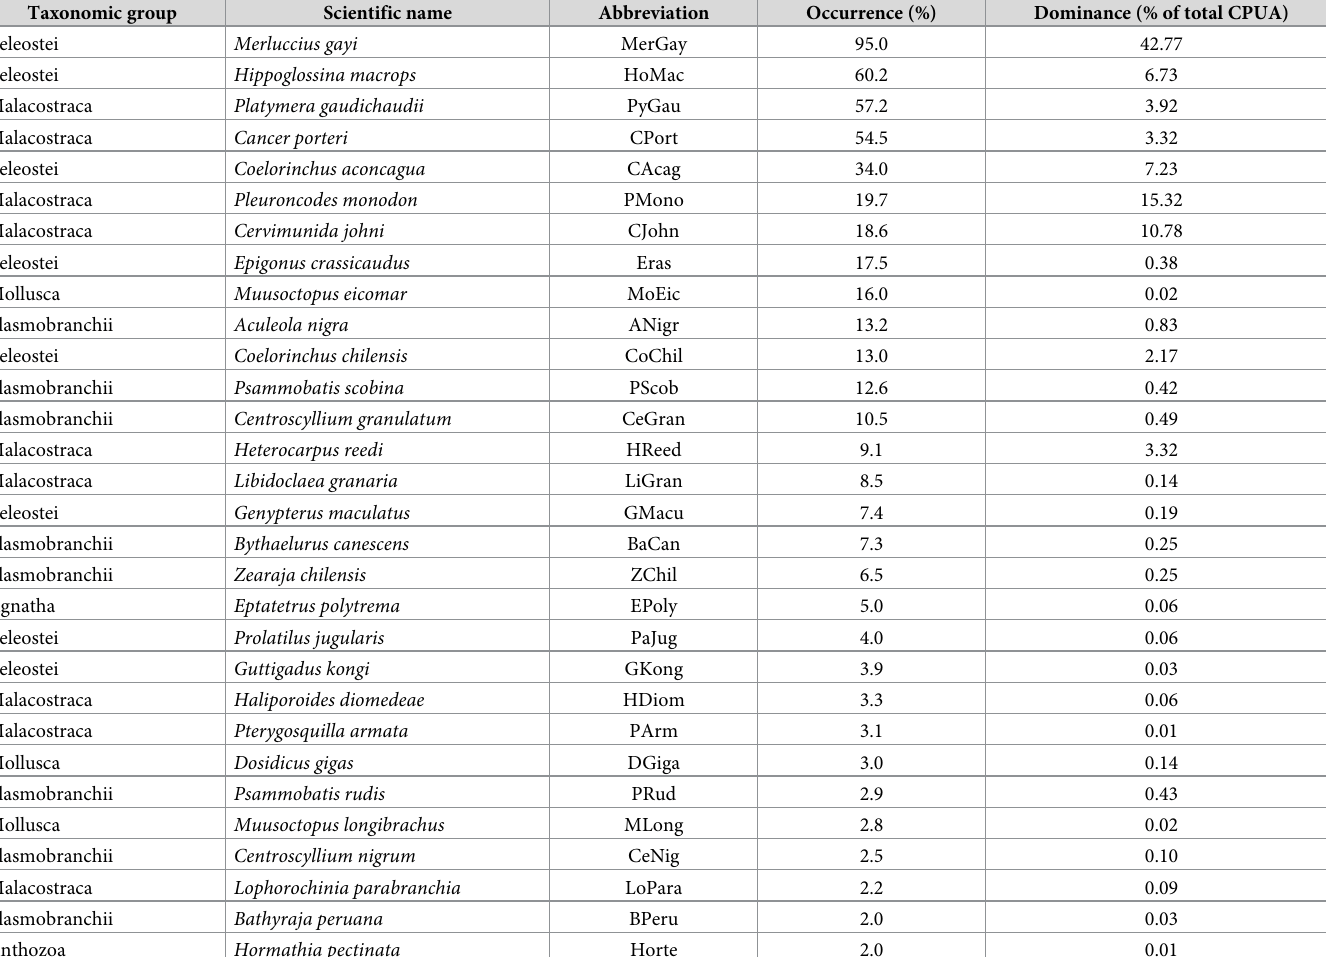
Table 1. Composition of the main species representing the discarded fauna associated with the artisanal and industrial fleet of the crustacean demersal fishery oper- ating off central Chile (28˚ to 38˚S) from 2014 to 2019. Taxonomic